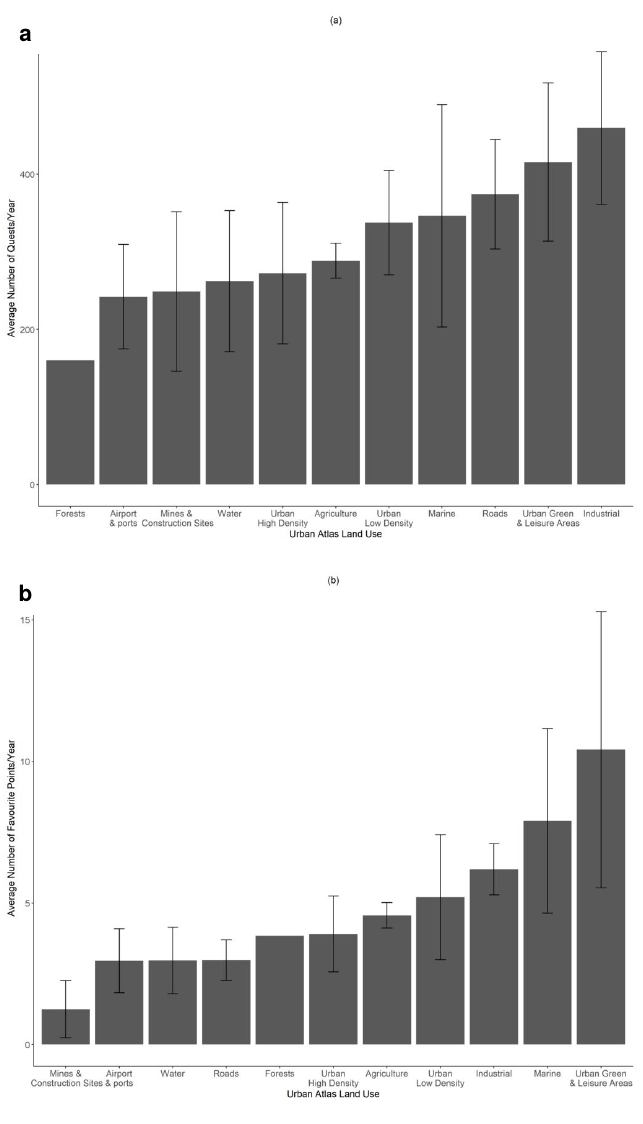
Figure 4. Mean number of (a) quests and (b) favourite points (± standard error of the mean) for the reclassi fi ed Urban Atlas land use categories a : Mean number of quests (± standard error of the mean) for the reclassi fi ed Urban Atlas land use categories b : Mean number of favourite points (± standard error of the mean) for the reclassi fi ed Urban Atlas land use